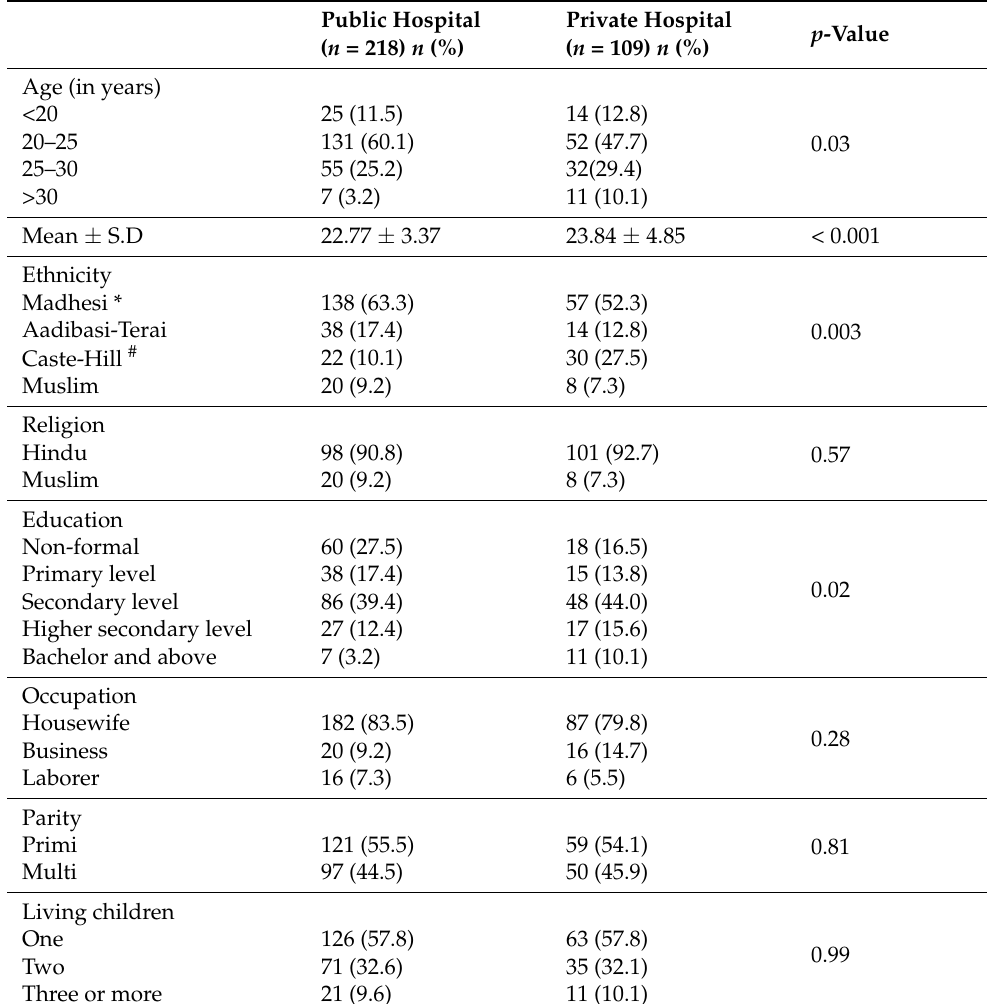
Table 2. Sociodemographic characteristics of respondents ( N =